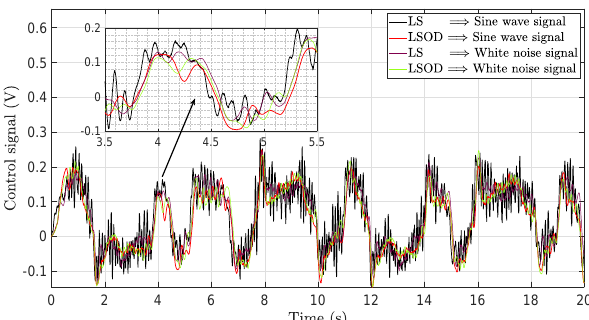
Figure 10. Control signals produced by control law (61) with parameter estimates β ∗